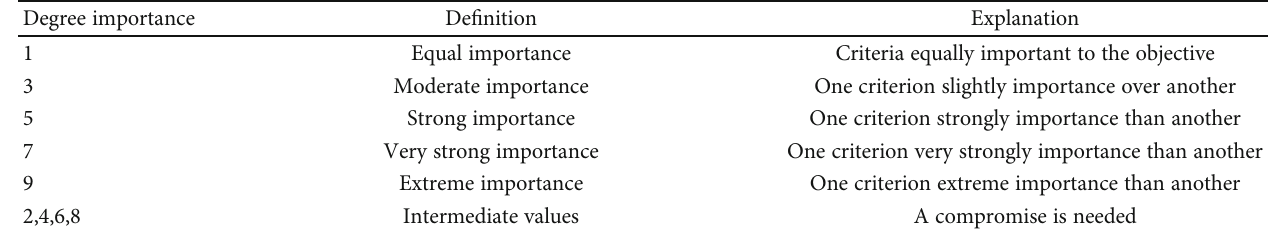
Table 2: Fundamental scale for pairwise comparisons [25, 26].